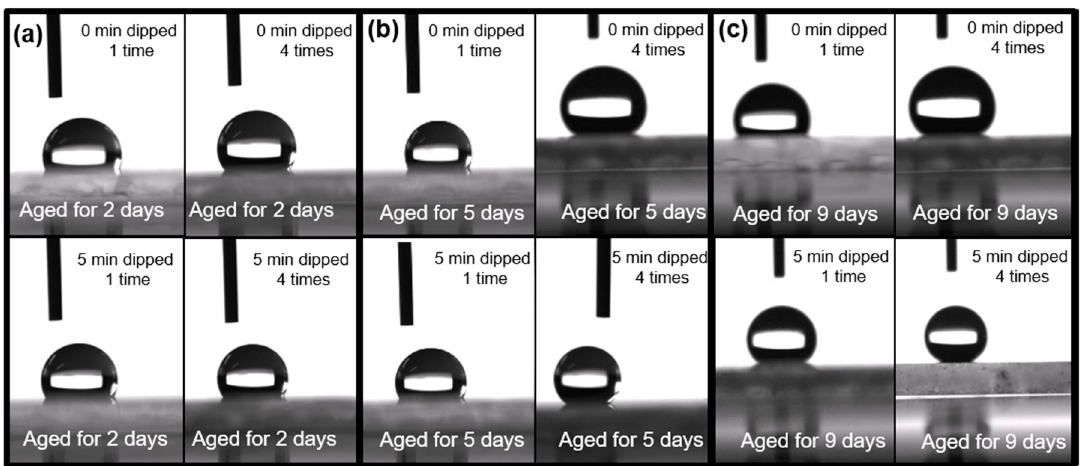
Figure 9. Water drop images on the coatings aged for ( a ) 2, ( b ) 5 and ( c ) 9 days.